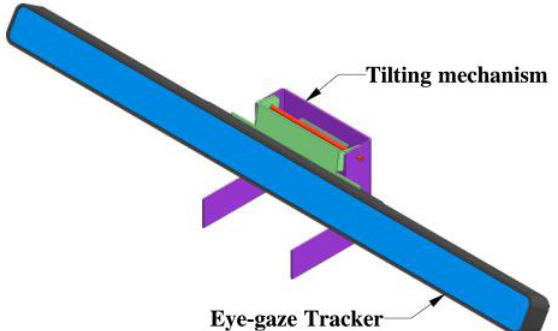
Figure 2. Tilting Figure 2. Tilting mechanism. Figure 2. Tilting mechanism.